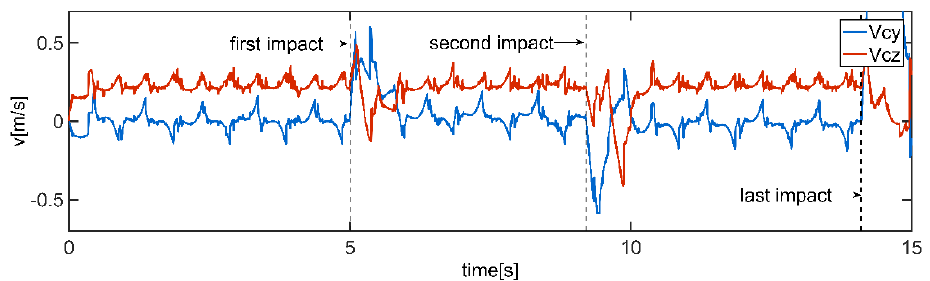
Figure 26. Velocities of the body in the 𝑦 𝑖 and 𝑧 𝑖 directions.